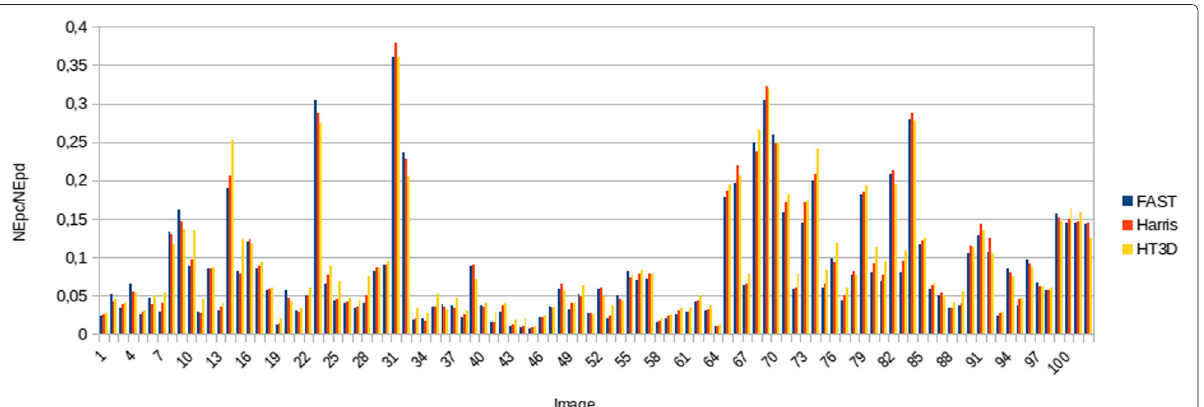
Fig. 16 Ratio between NEp c (number of correct matchings between ground truth and detected points) and NEp d (total number of detected points) for the whole dataset considering d Ep = 3 (distance between ground truth and detected points). A low value of this ratio for one detector in relation to other methods is indicative of a high number of false alarms. As it can be observed in this figure, the ratio remains almost constant in the three methods for most of the test images, which denotes similar rates of false alarms in the three detectors